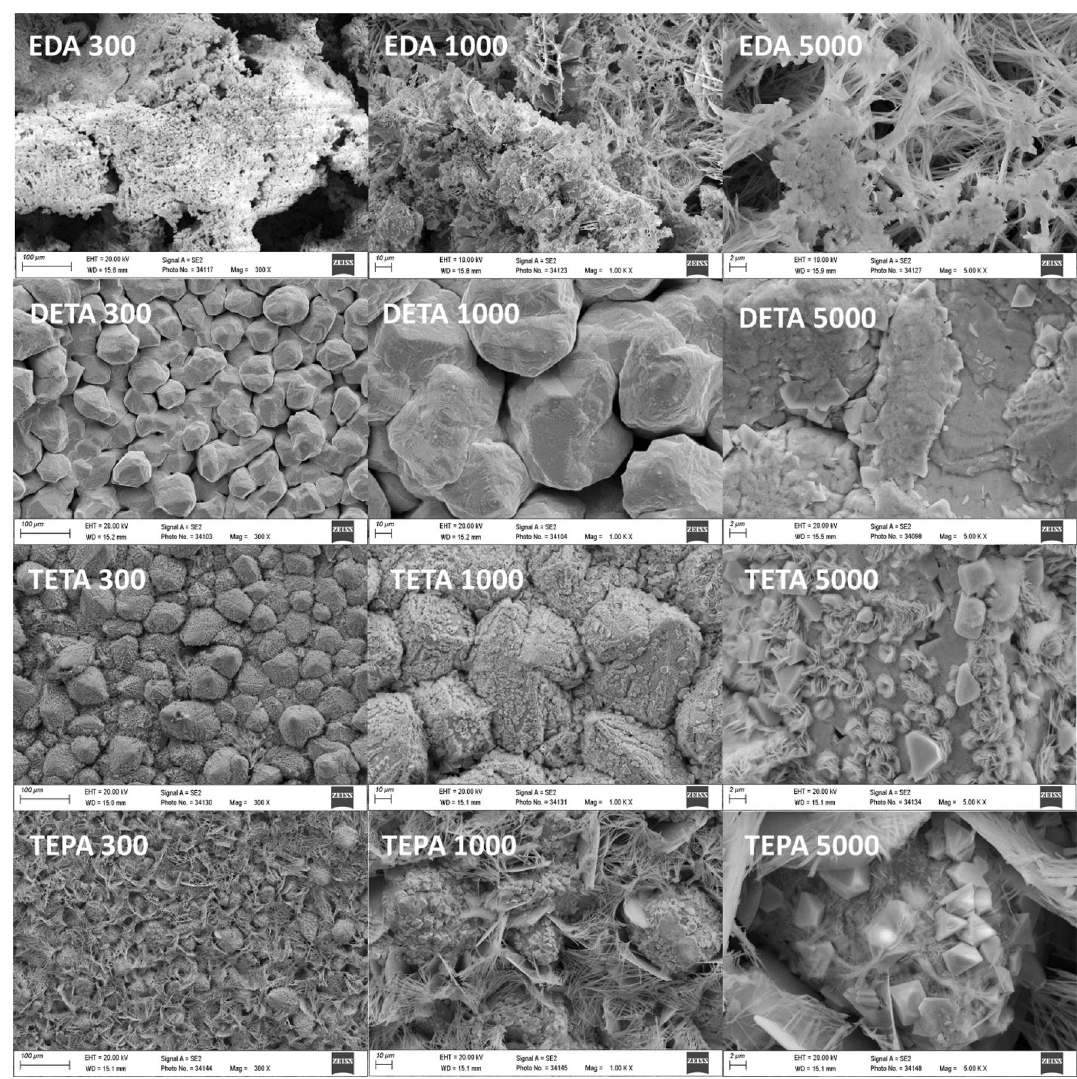
Fig. 3 SEM images of lead deposits oregistered at different